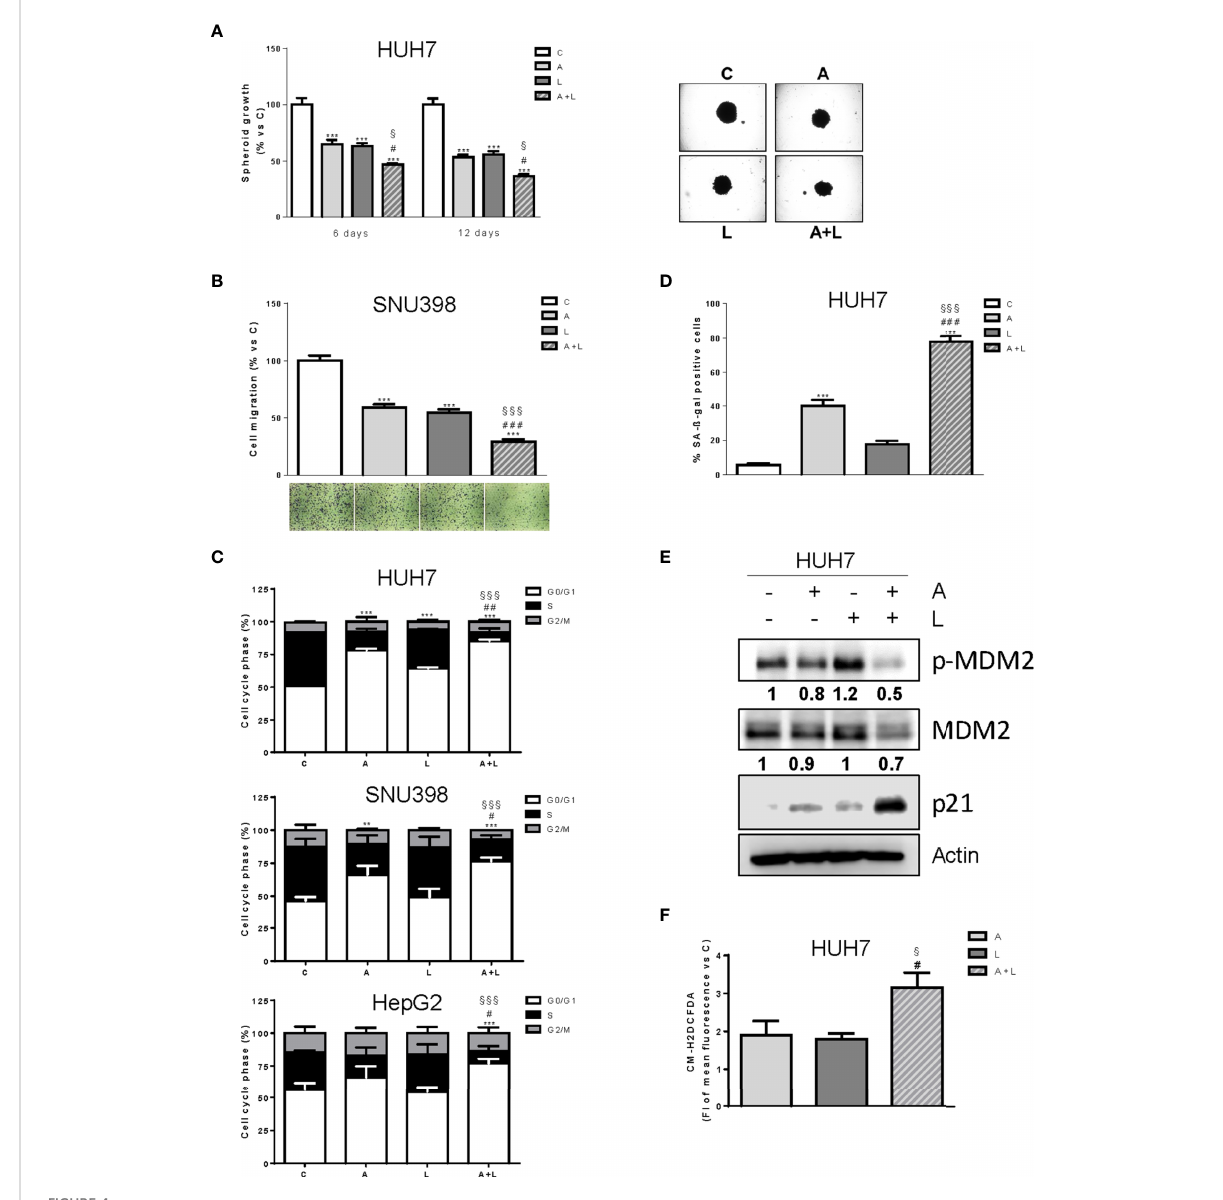
FIGURE 4 Abemaciclib combined with lenvatinib reduces 3D cell growth, inhibits cell migration, and induces G1 cell cycle arrest associated with senescence. (A) The growth of spheroids from HUH7 was analyzed after 6 or 12 days of treatment with 0.1 m M A and 0.5 m M L alone or in combination. The data are expressed as percent of spheroid growth versus control. Representative images of spheroids after 12 days of culture are shown. ***p<0.001 vs C; # p<0.05 vs A; § p<0.05 vs L. (B) SNU398 cells were treated with 0.2 m M A or 2 m M L as single treatment or in combination for 20h. Migrated cells were then counted. Data are expressed as percent versus control. Representative fi elds of migration are shown (magni fi cation of 4×). ***p<0.001 vs C; ### p<0.001 vs A; §§§ p<0.001 vs L. (C) HUH7, SNU398, and HepG2 cells were untreated (C) or treated with 0.1, 0.2 m M and 0.05 m M A and 0.5, 2 or 6.5 m M L for HUH7, SNU398 and HepG2, respectively, as single treatment or in combination for 24h. After 24h the cells were stained with propidium iodide and cell-cycle-phase distribution was determined by fl ow cytometry. Data are expressed as percentage of cells in each cell-cycle phase. **p<0.01, ***p<0.001 vs C; # p<0.05, ## p<0.01 vs A; §§§ p<0.001 vs L. (D) HUH7 cells were treated with 0.1 m M A and 0.5 L alone or in combination for 6 days. Histograms represent the percentage of senescent cells positive for SA- b -Gal expression. ***p<0.001 vs C; ### p<0.001 vs A; §§§ p<0.001 vs L. (E) HUH7 was treated with 0.1 m M A and 0.5 L alone or in combination for 3 days. The cells were lysed and the expression of the indicated proteins was evaluated by Western blot analysis. (F) HUH7 were treated with 0.1 m M A and 0.5 L alone or in combination. After 6 days, the cells were incubated with 1 m M CM-H2DCFDA probe and analyzed by fl ow cytometry. # p<0.05 vs A; § p<0.05 vs L. Experiments in A-E are representative of two independent experiments. Data in (B, C) are mean values ± SD of two independent experiments. Data in D are mean values ± SD of three independent experiments. Data in F are mean values ± SD of three independent